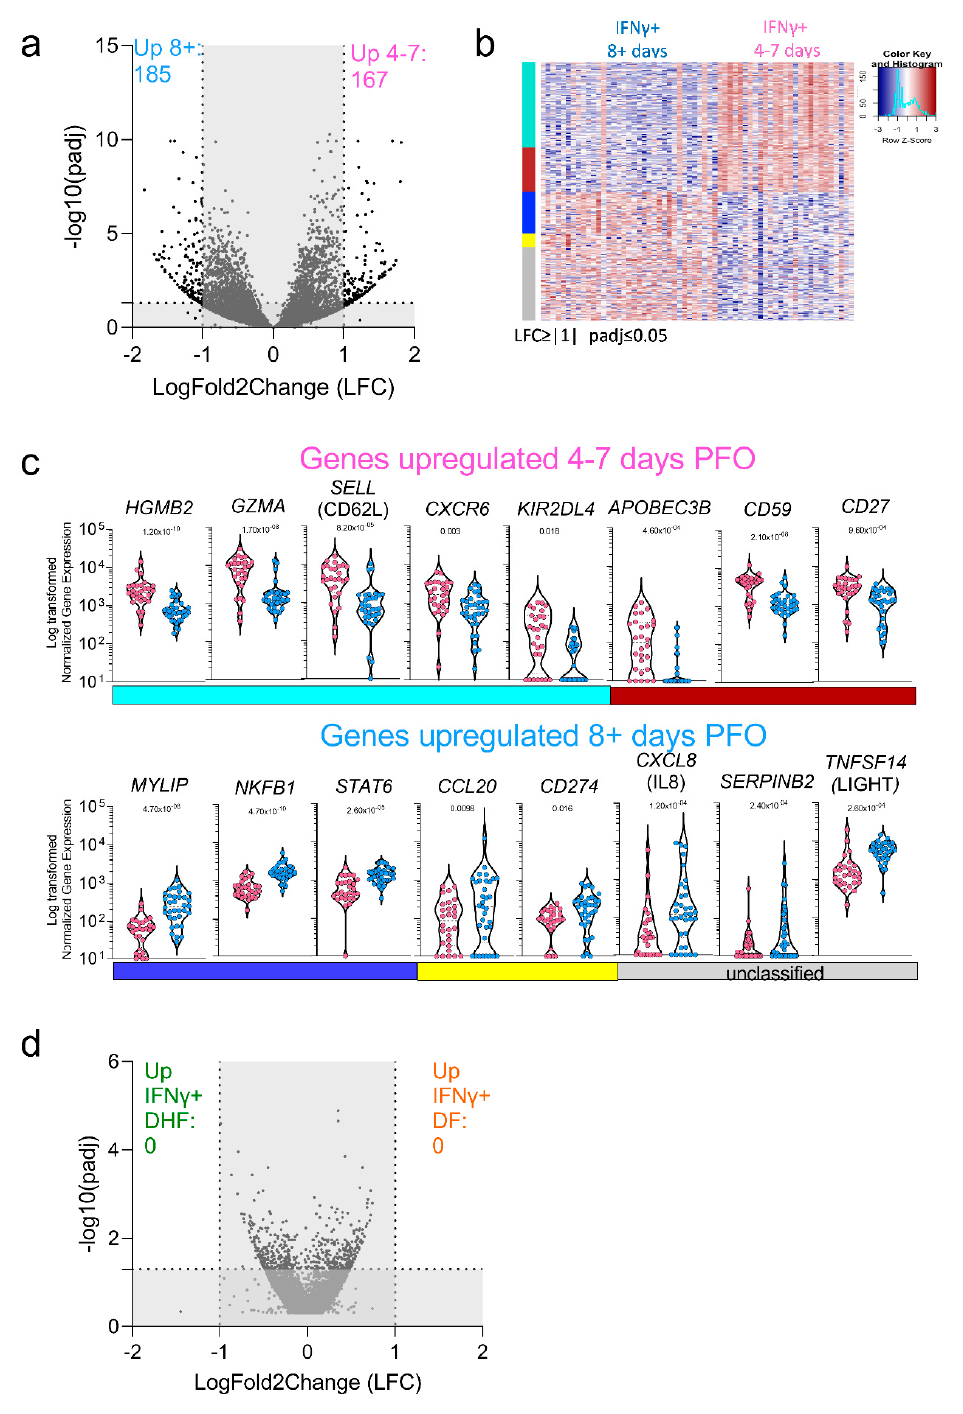
Figure 4. DE genes related to DENV-specific CD8+ IFN γ + T cells signature. ( a ) Volcano plot of differential expressed genes plotted based on their adjusted p -values and log2 fold change gene expression in early and late phase of infection. ( b ) Heatmap of the most significantly differentially expressed genes in early (4–7 days PFO) and late (8 + days PFO) samples. ( c ) Normalized counts of selected genes upregulated in early or late samples. ( d ) Volcano plot of differential expressed genes plotted based on their adjusted p -values and log2 fold change gene expression in DF and DHF samples. All the analyses have been carried out considering significant genes with a log2 fold change gene expression less than − 1 and greater than 1 and adjusted p -values less than